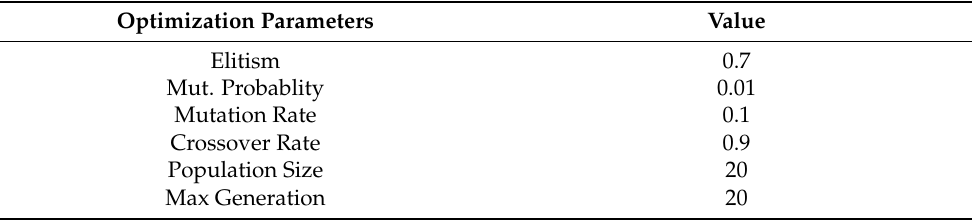
Table 13. Octopus optimized parameter